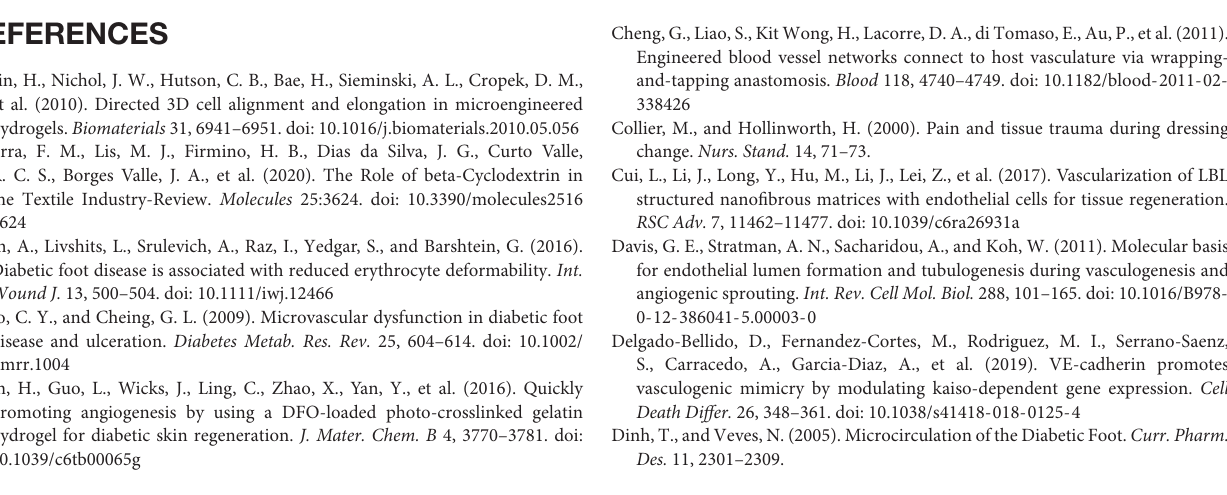
Supplementary Figure 4 | Shear wave elastography (SWE) and water contact angle (WCA) results of hydrogels. (A) Young’s modulus of hydrogels. The hydrogels in all groups were soft, and the Young’s modulus of hydrogels increased with increasing β -cd content. (B) Hydrophilicity of hydrogels. All groups of hydrogels were hydrophilic, and the hydrophilicity decreased with increasing β -cd content. [Label descriptions: (a) pure GelMA, (b) with 2% β -cd, (c) with 3% β -cd, and (d) with 4% β -cd]. Supplementary Figure 5 | The key port of the control module, the different working states of the sensor and the construction process of the integrated smart dressing. (A) . The key interface of the control module of the integrated smart dressing. (B) Different working states of the microenvironment sensor in vitro . (a) Signal search. (b) Upon connection. (c) Display interface. (d) Turn off the switch. (C) The manufacturing process of the integrated smart dressing. (D) Integrated